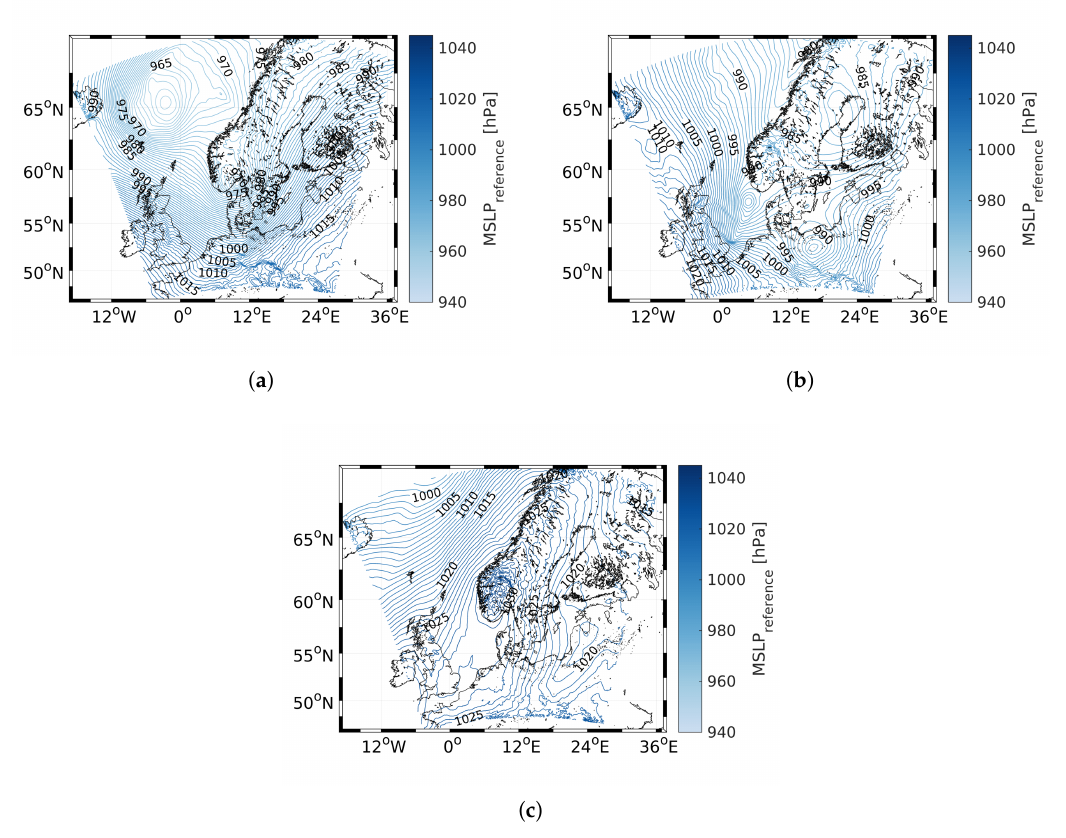
Figure 8. Mean sea level pressure (MSLP) on ( a ) 11 January 2017 at 12:00 p.m. UTC; ( b ) 13 January 2017 at 12:00 p.m. UTC; and ( c ) 16 January 2017 at 6:00 a.m.